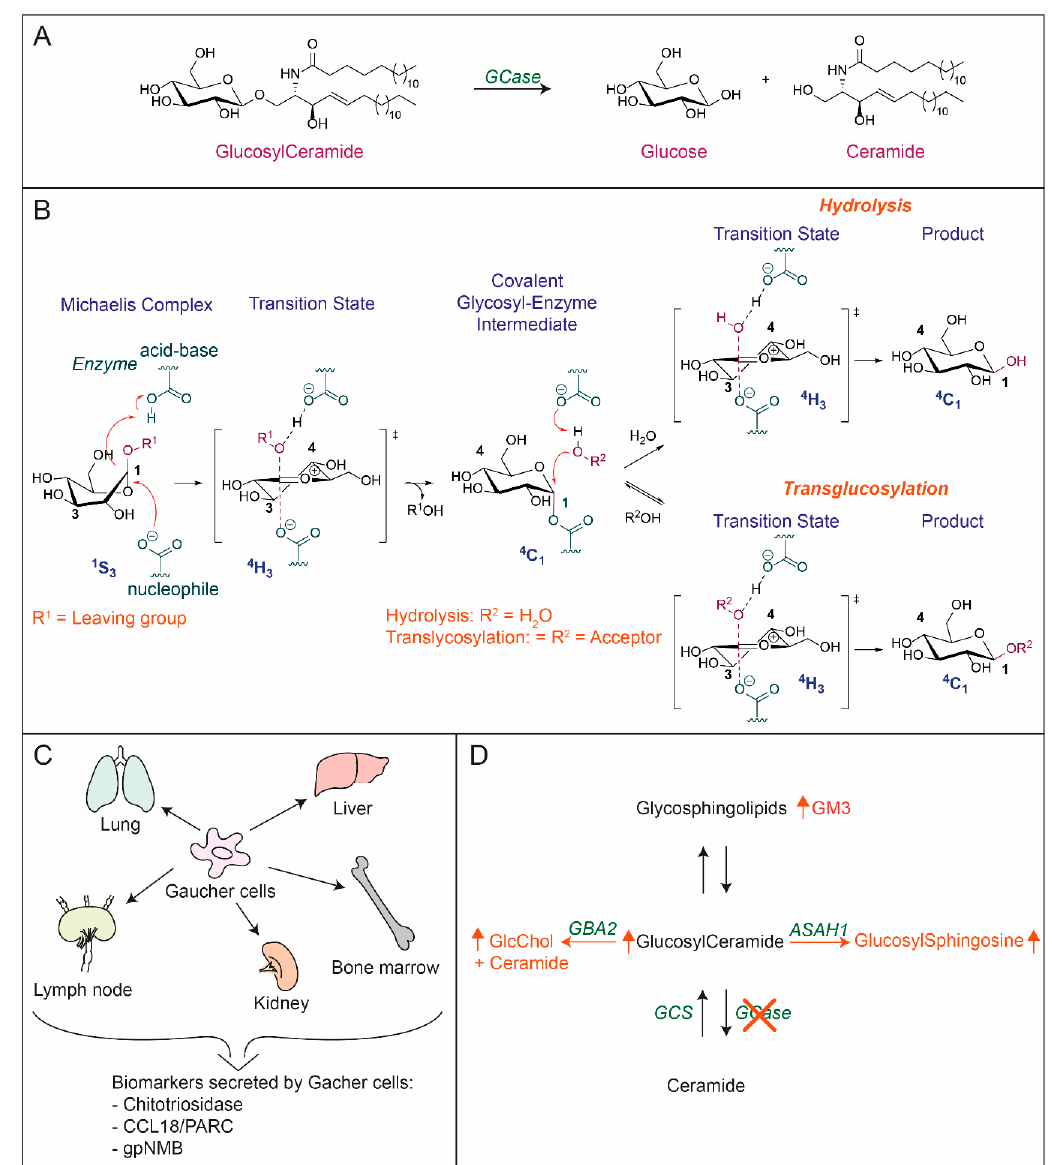
Figure 1. ( A ) Structure of glucosylceramide (GlcCer) and degradation by GCase to glucose and ceramide. ( B ) Catalytic activity GCase: Hydrolyzation of β -glucosides and transglucosylation activity. ( C ) Occurrence of Gaucher cells and the biomarkers they secrete in plasma. ( D ) Metabolic adaptations to GCase deficiency: increase of GlcCer as a result of lack of degradation by GCase. Accumulated GlcCer is converted by ASAH1 to glucosylsphingosine, Glucosylated cholesterol (GlcChol) formed by GBA2 increases, and GM3 levels rise because increased anabolism by glycosyltransferases to complex GSLs. Enzymes are depicted in green. ASAH1: acid ceramidase, GBA2: cytosolic β -glucosidase, GCase: β -glucocerebrosidase, GCS: glucosylceramide synthase.